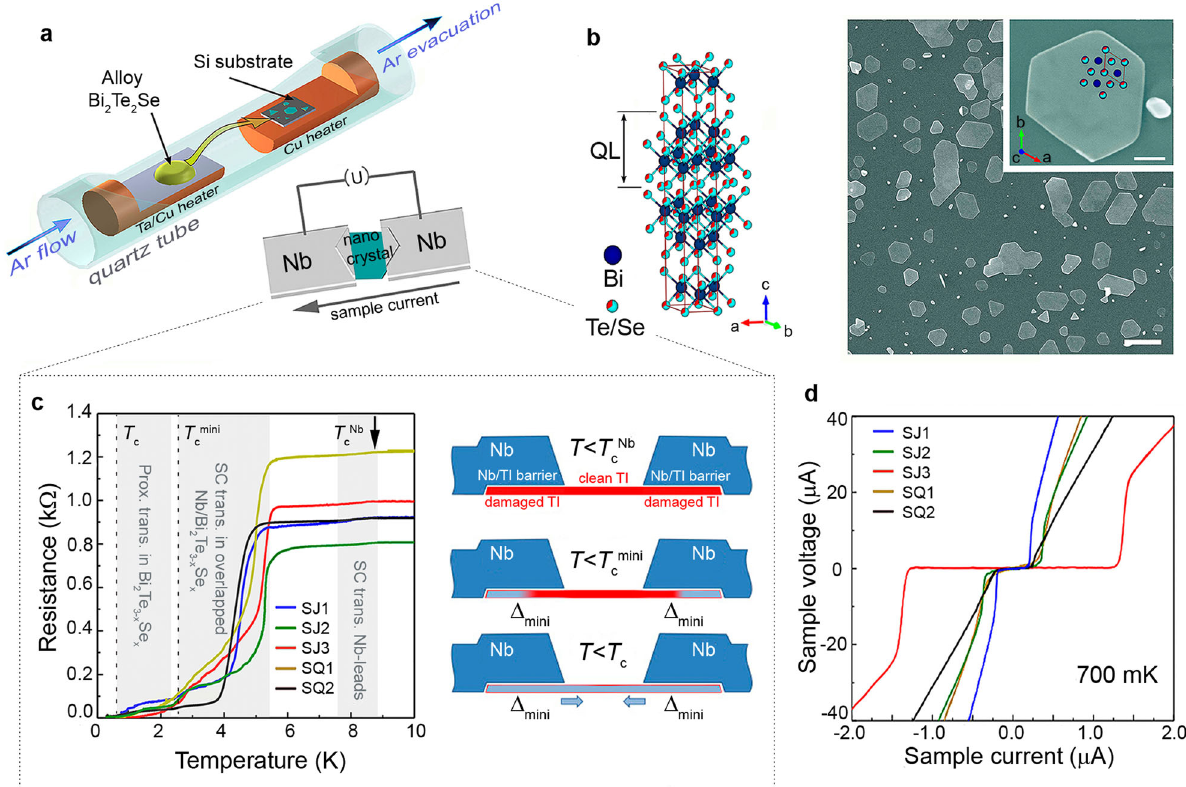
Fig. 1 Topological Josephson junctions: growth and properties. a Schematic view on the physical vapor deposition (PVD) growth cell. The Bi 2 Te 3 − x Se x nanocrystals grow on Si substrate by Ar- fl ow-assisted atomic transport from the evaporated target (Bi 2 Te 2 Se alloy). Inset: schematics of the Josephson junctions studied in this work. The junctions are made of a single nanocrystal contacted by overlaying Nb electrodes. b Atomic structure of Bi 2 Te 3 − x Se x with presented crystallographic axes and quintuple layer (QL) marker, SEM image of the substrate covered by Bi 2 Te 2.3 Se 0.7 nanocrystals, respectively. Inset: a top view on a selected crystal with superposed crystallographic axes and atomic structure. White scale bars correspond to 1 μ m and 100 nm, respectively. c Temperature dependence of the two-terminal device resistance R ( T ) and various steps of the transition of devices to the superconducting (SC) state. Characteristic temperatures of the superconducting transition of Nb leads, overlapped Nb/Bi 2 Te 2.3 Se 0.7 contacts, and open parts of Bi 2 Te 2.3 Se 0.7 are shown by an arrow and two vertical dashed lines. The three steps of the transition are colored in gray. Schematic view on three steps of the transition, the superconducting parts are colored in blue/gray, normal parts — in red. TI — topological insulator, Δ mini — superconducting mini gap, T c , — critical temperatures at different stage. d Current – voltage I ( V ) characteristics of the devices SJ1, SJ2, SJ3, and SQ1, SQ2 at T = 700 mK in zero T Nb , T mini c c magnetic fi eld manifest Josephson junction behavior, SEM scanning electron